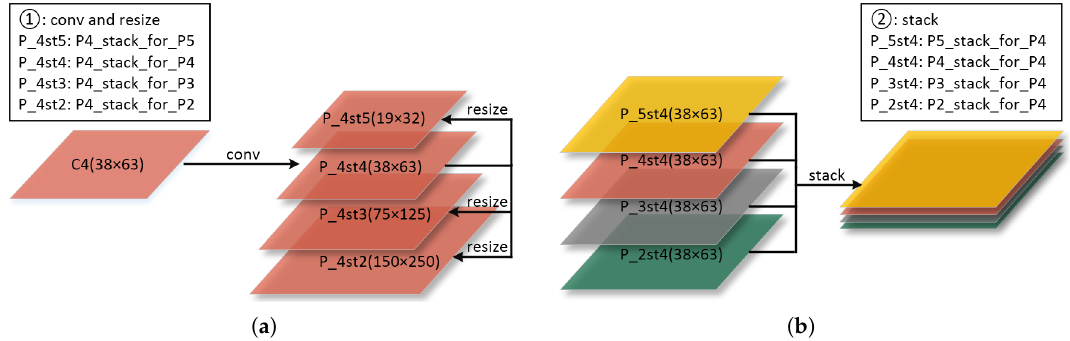
Figure 3. C4 feature map fusion process in a Feature Fusion Pyramid Network. ( a ) the convolution and resizing based on the original feature map C4; ( b ) the stacking operation based on the intermediate feature